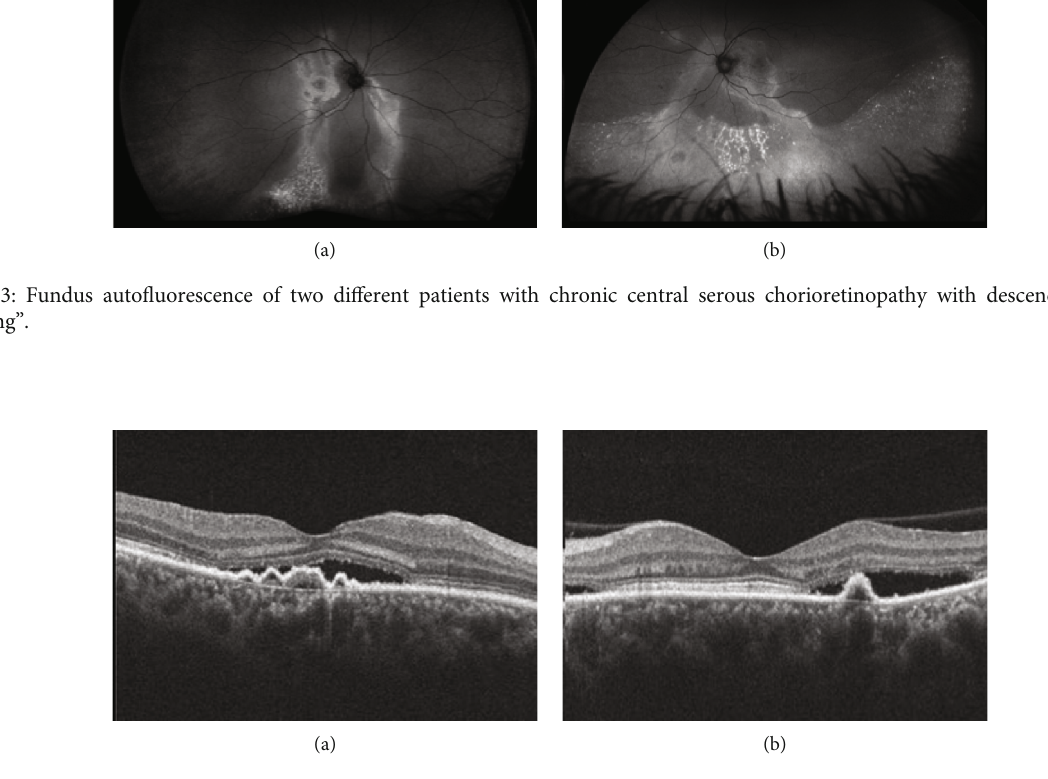
Figure 4: Optical coherence tomography in central serous chorioretinopathy. Note multiple pigment epithelial detachments, subretinal fl uid, and “ shaggy ” photoreceptors.